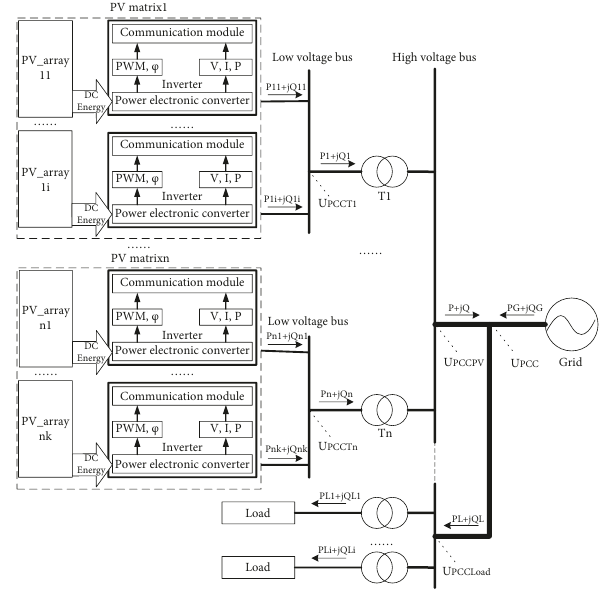
Figure 1: Topology of distributed